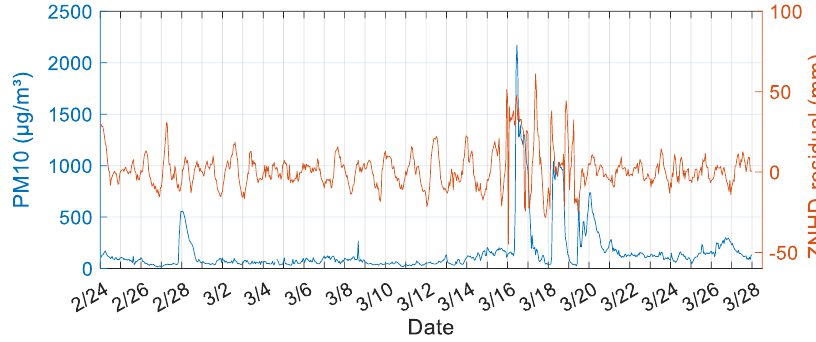
Figure 10. Variations in the PM10 and ZNHD residual at GSPL station.